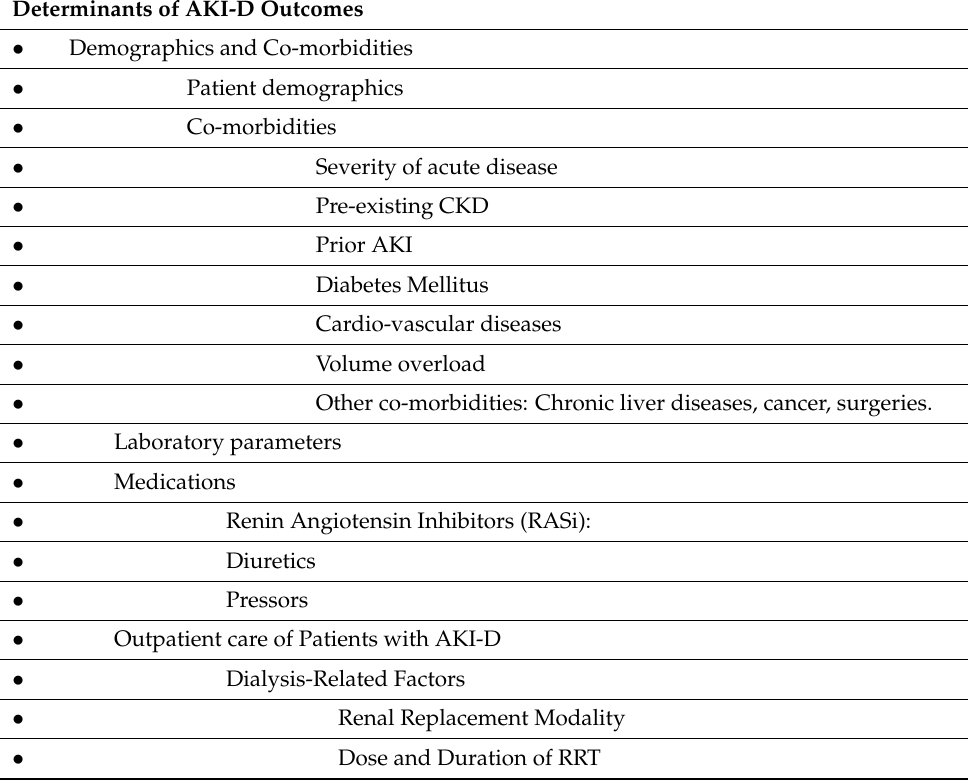
Table 1. Determinants of AKI-D